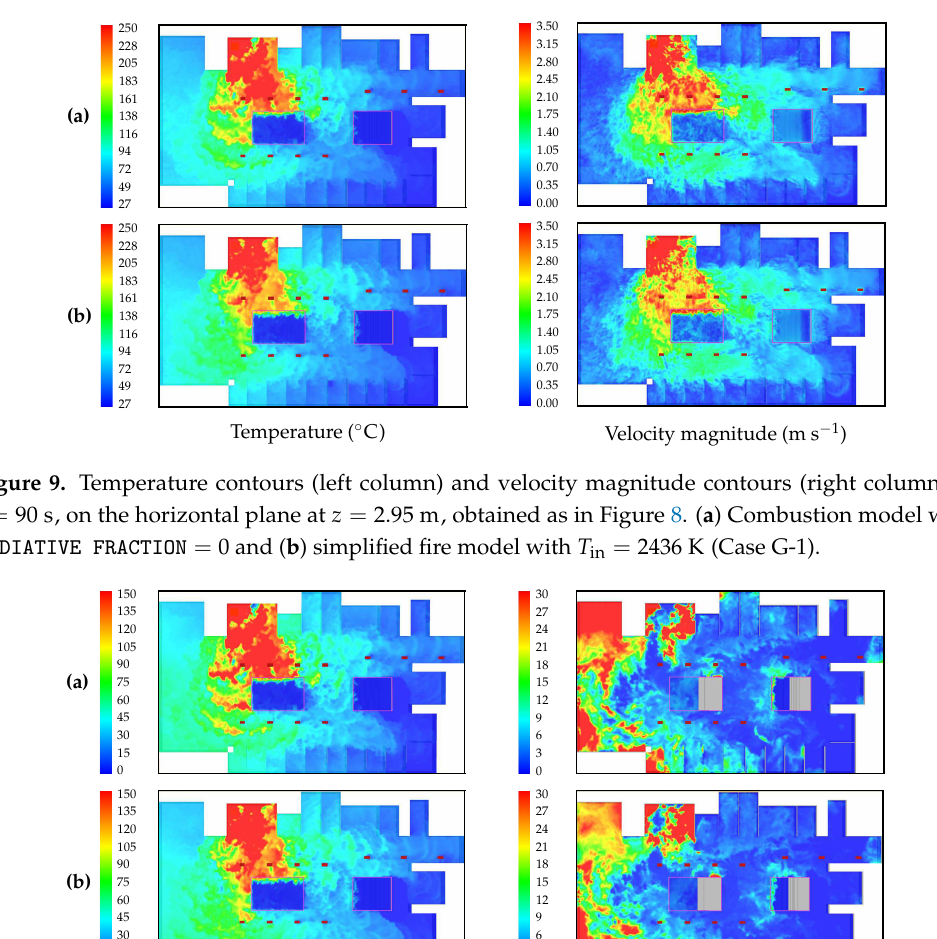
Figure 10. Contours of CO 2 mass fraction ( Y CO 2 × 10 4 ) at t = 90 s and heights z = 2.95 m (left column) and z = 2.05 m (right column), obtained as in Figure 8. ( a ) Combustion model with RADIATIVE FRACTION = 0 and ( b ) simplified fire model with T in = 2436 K (Case